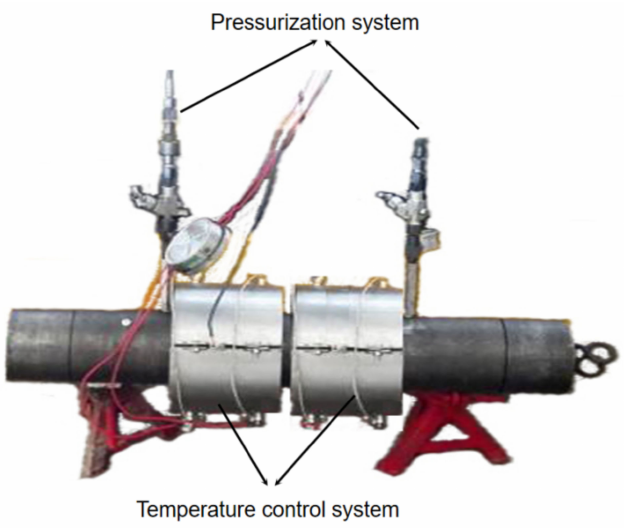
Figure 13. High-temperature and high-pressure experimental device.